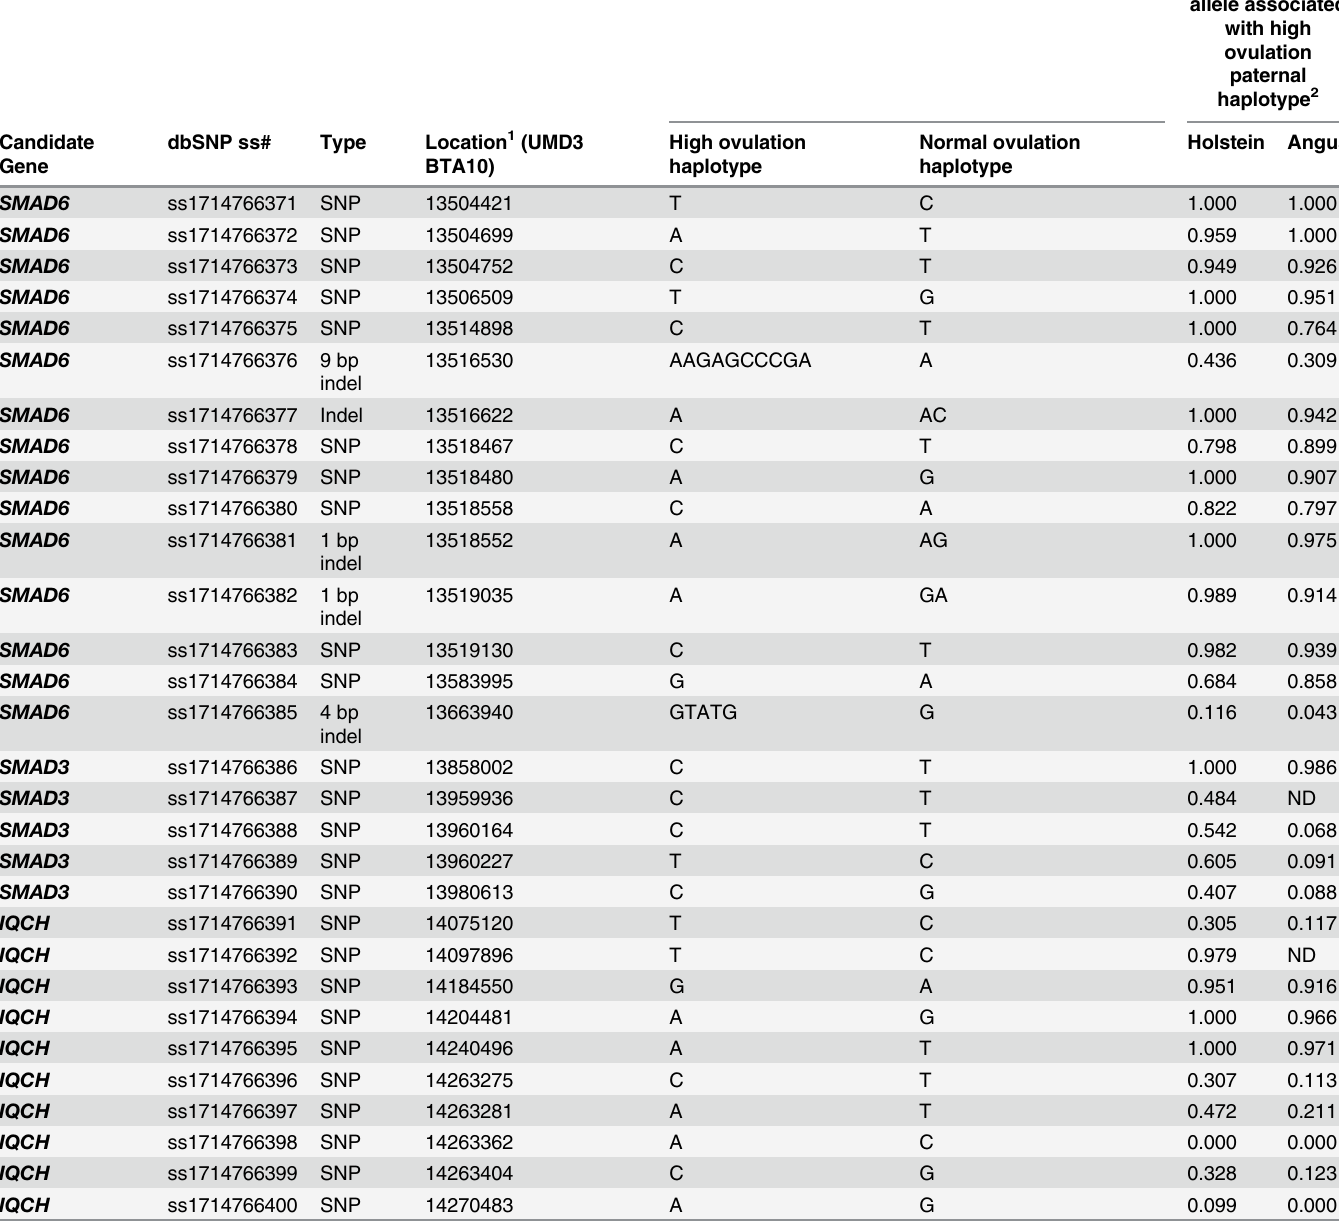
Table 2. Validated polymorphisms within positional candidate